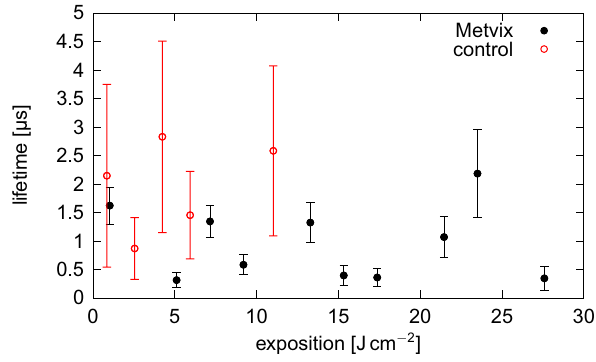
Fig. 12. Singlet oxygen phosphorescence rise times exhibit exposition dependence neither in Metvix treated (solid) nor in control (open)